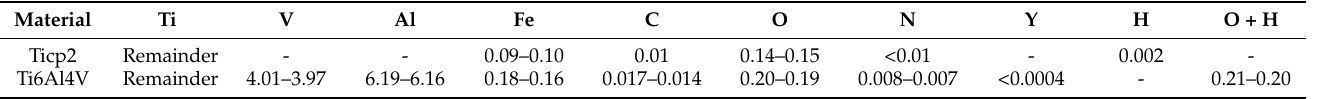
Table 1. Chemical composition of the analyzed titanium alloys